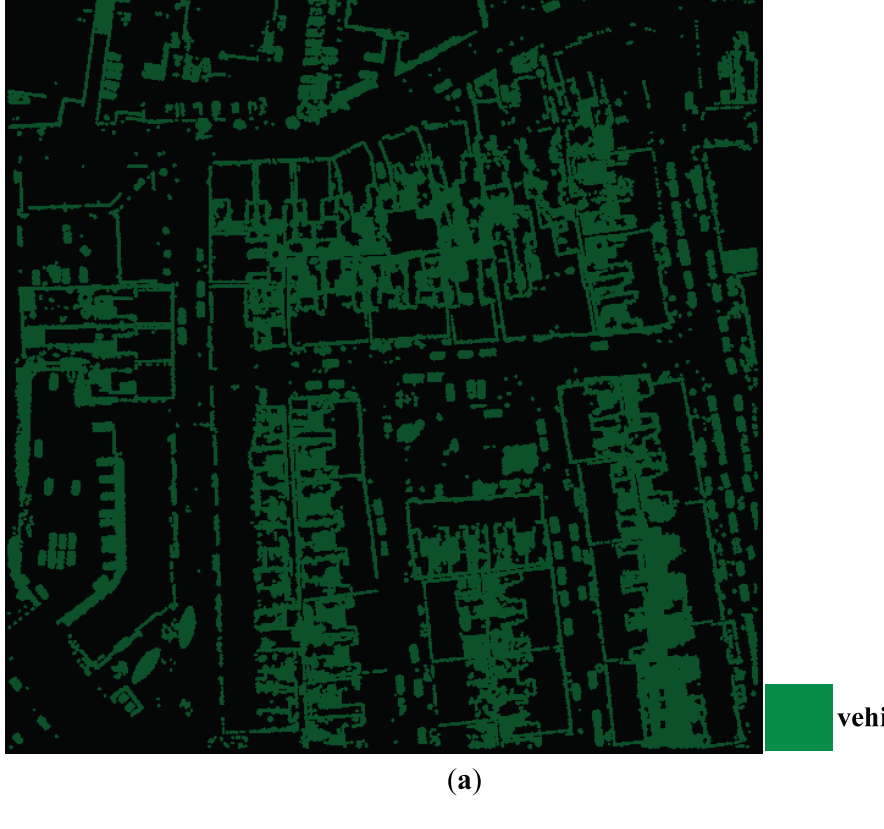
Figure 3. 3D connected component analysis (CCA) for potential vehicle points. ( a ) The potential vehicle points in the point cloud in Figure 1c. ( b ) 3D CCA result (note that each potential vehicle segment is drawn with a random